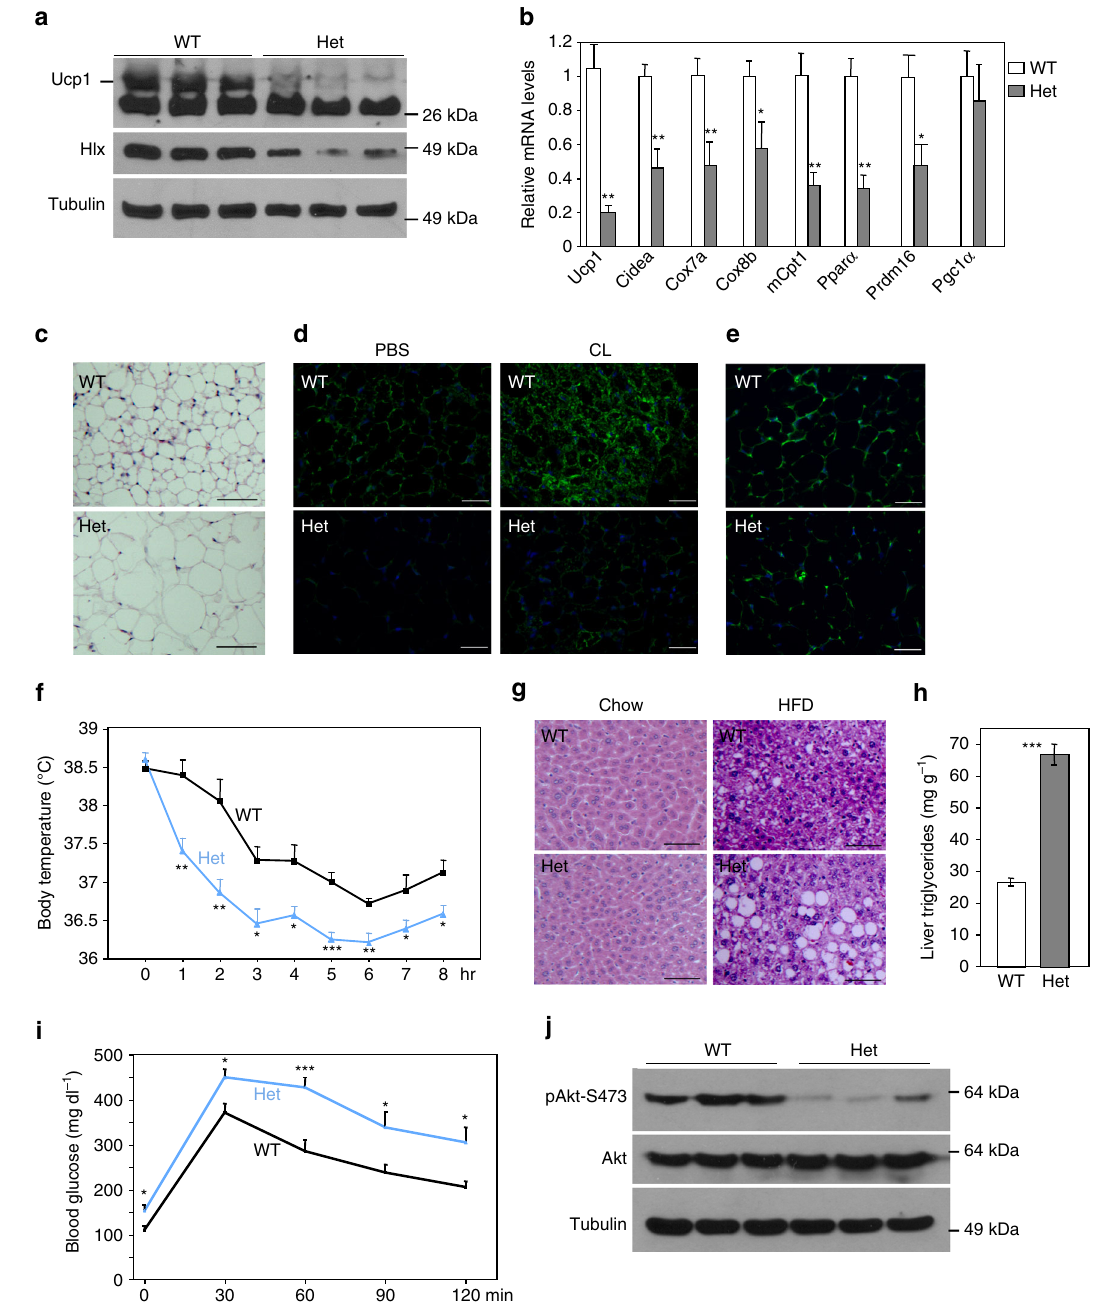
Fig. 4 Loss of beige adipocytes, glucose intolerance and hepatic steatosis in Hlx heterozygous mice. a Western blot analysis of Ucp1 and Hlx protein in iWAT of 8-week-old male Hlx heterozygous mice and littermate controls. b qPCR analysis of gene expression in iWAT of 12-week-old male Hlx heterozygous mice ( n = 5) and littermate controls ( n = 7). c H&E staining of iWAT of 8-week-old male Hlx heterozygous mice and littermate controls. Shown are representative images of three mice per genotype. Scale bar , 200 µ m. d Ucp1 immuno fl uorescence staining of iWAT of 8-week-old male Hlx heterozygous mice and littermate controls that has received daily CL-316243 or PBS intraperitoneal injection for 10 days. Shown are representative images of three mice per genotype. Green , Ucp1; blue , DAPI. Scale bar , 200 µ m. e iWAT of 10-week-old male Hlx heterozygous mice and littermate controls was immunostained with a Tom20 antibody. Shown are representative images of three mice per genotype. Green , Tom20; blue , DAPI. Scale bar , 200 µ m. f Body temperature of 8-month-old male Hlx heterozygous mice ( n = 8) and littermate controls ( n = 6) at 4 °C. g H&E staining of liver of Hlx heterozygous mice on a normal chow or on a high-fat diet for 11 weeks. Shown are representative images of three mice per genotype. h Hepatic triglyceride content of Hlx heterozygous mice and littermate controls ( n = 3 per genotype) on a high-fat diet for 11 weeks. i Glucose tolerance test of 10-month-old male Hlx heterozygous mice and littermate controls ( n = 7 mice per group). j Phosphorylation level of Akt at residue S473 in iWAT. All error bars represent s.e.m. Two-tailed unpaired Student ’ s t-test was performed. * p < 0.05; ** p < 0.01; *** p <